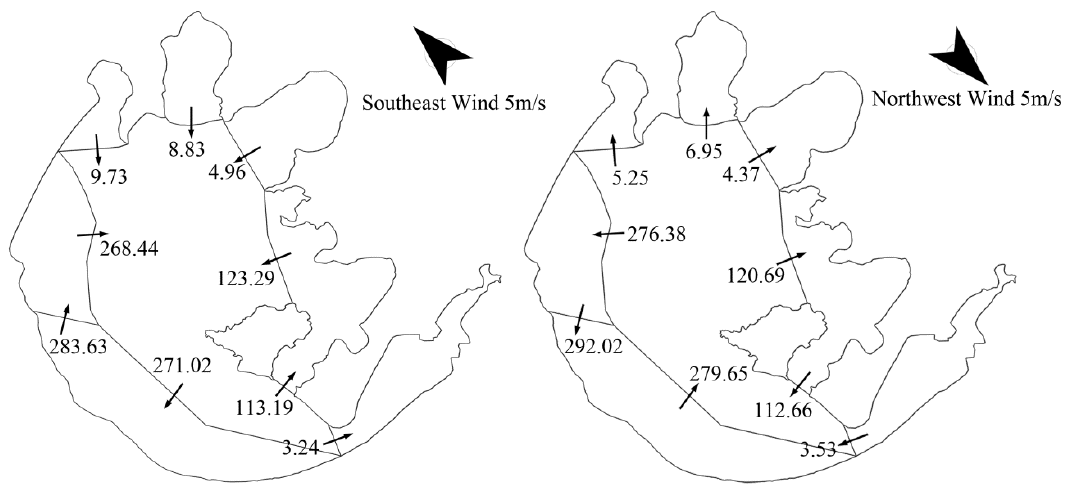
Figure 5. Volume exchange between subbasins, with constant wind unit of numbers shown in the figure in m 3